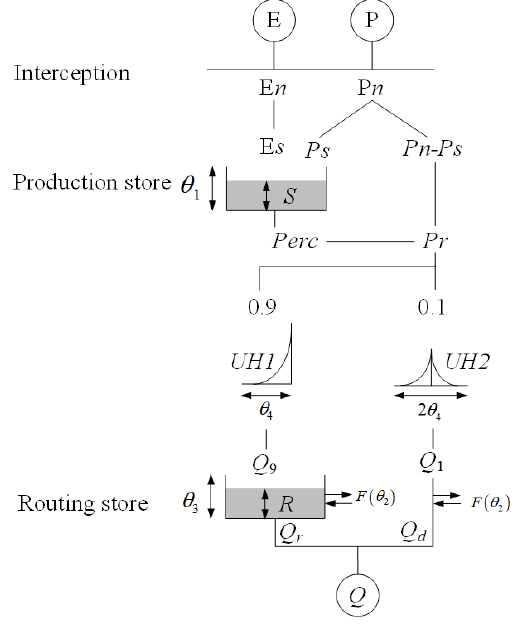
Figure 4. Diagram of the GR4J model proposed by Perrin et al.